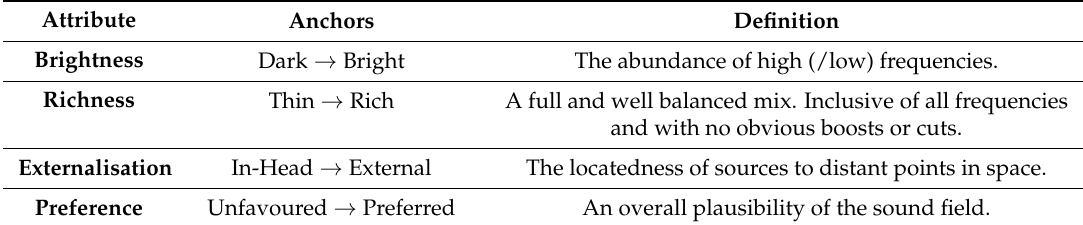
Table 1. Spatial audio attribute scales and